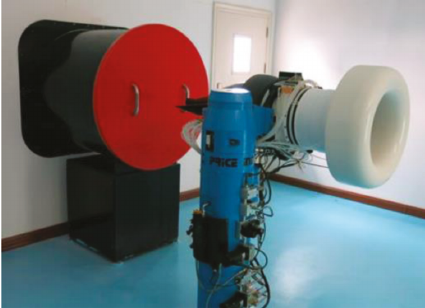
Figure 2: DGEN380 aero engine test